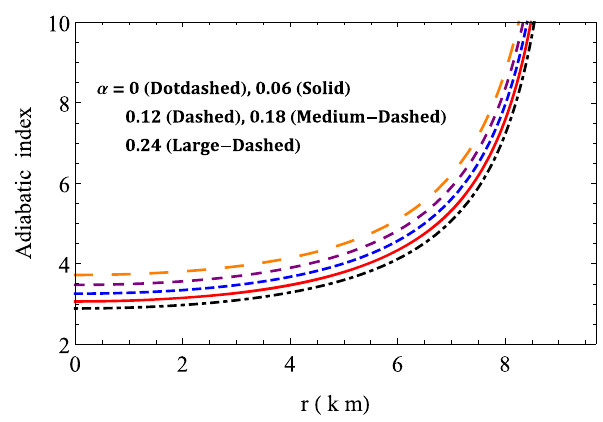
Fig. 7 Variation adiabatic index with r for M = 1 . 97 M (cid:3) , R